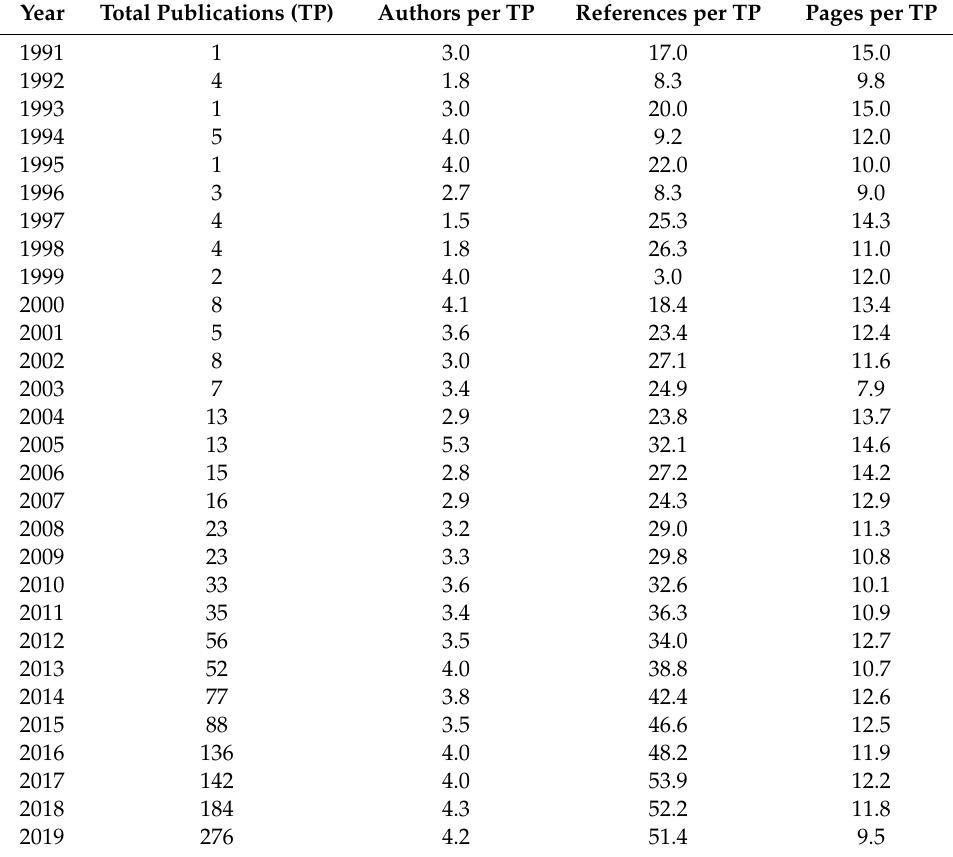
Table 2. The development of scientific publications on municipal energy system planning between 1991 and 2019. Authors per